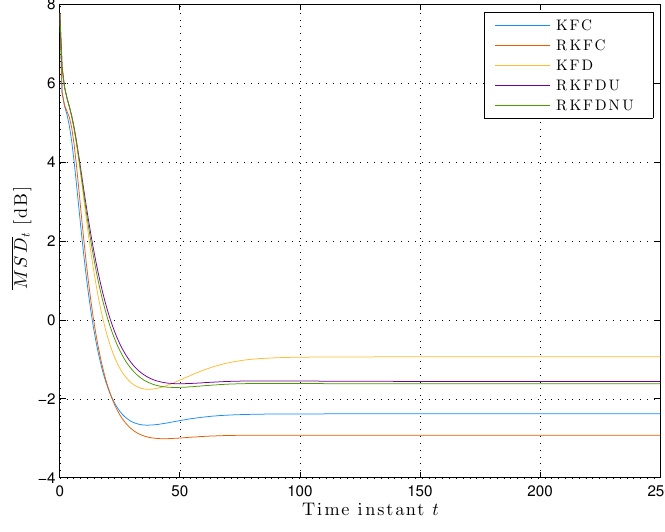
Figure 2. Least favorable mean square deviation across the network with tolerance c = 0.02.